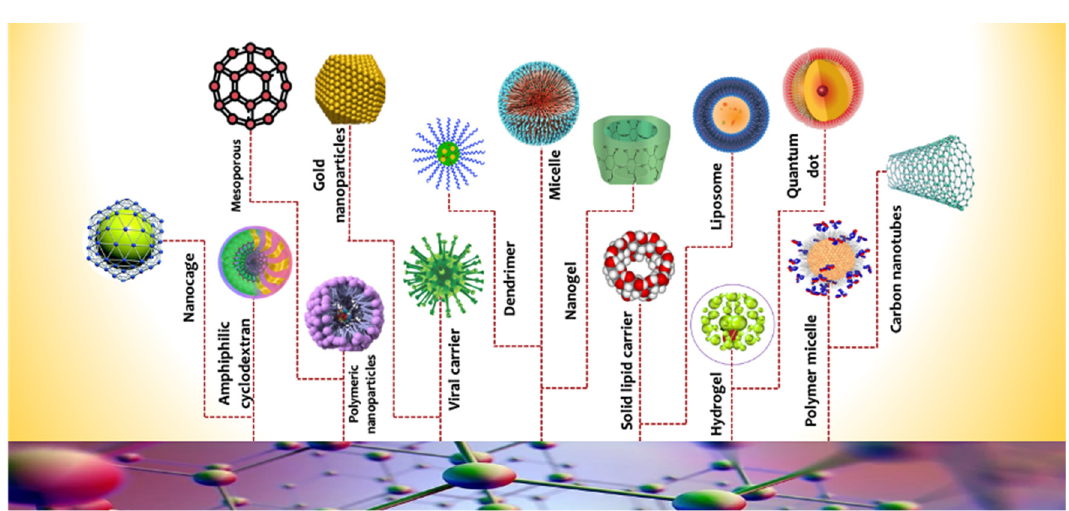
Figure 1. Types of polymeric nanoparticles.